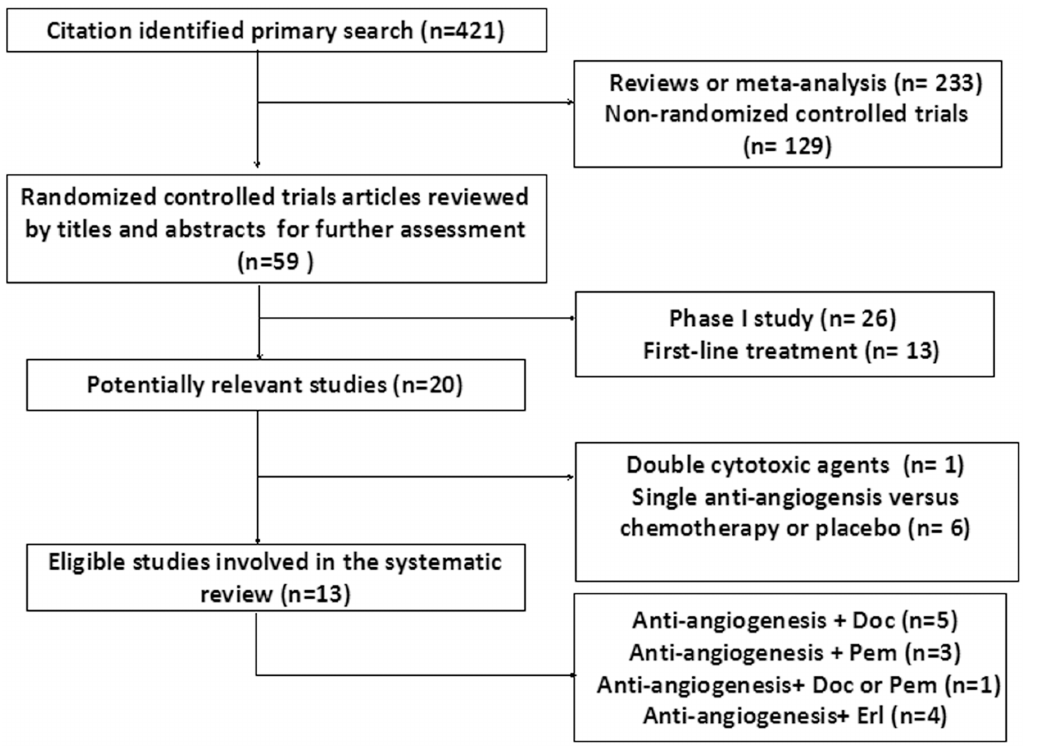
Fig 1. The flowchart of the process for selecting relevant